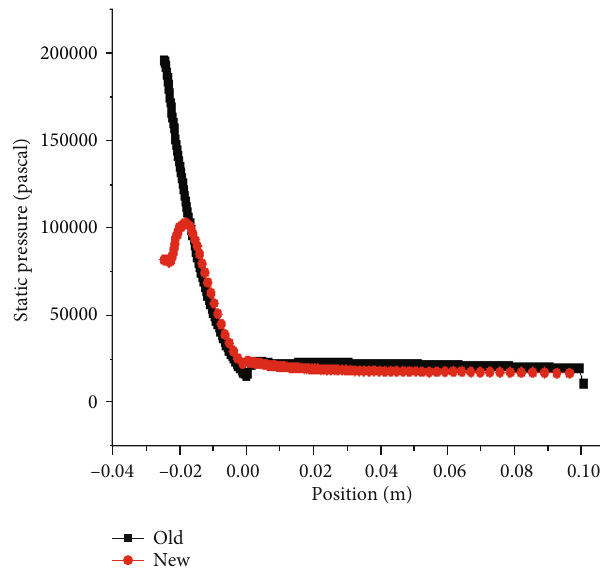
Figure 16: Comparison of pressure distribution between a single recti fi er cone and a blu ff